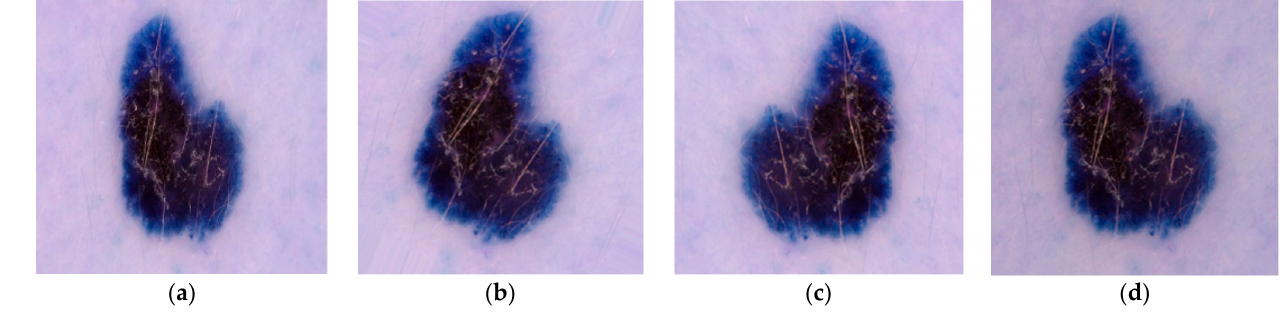
Figure 3. Data Augmentation Techniques in Sequence ( a ) Input Image, ( b ) Rotated Image, ( c ) Flipped Image, ( d ) Brightened Image.